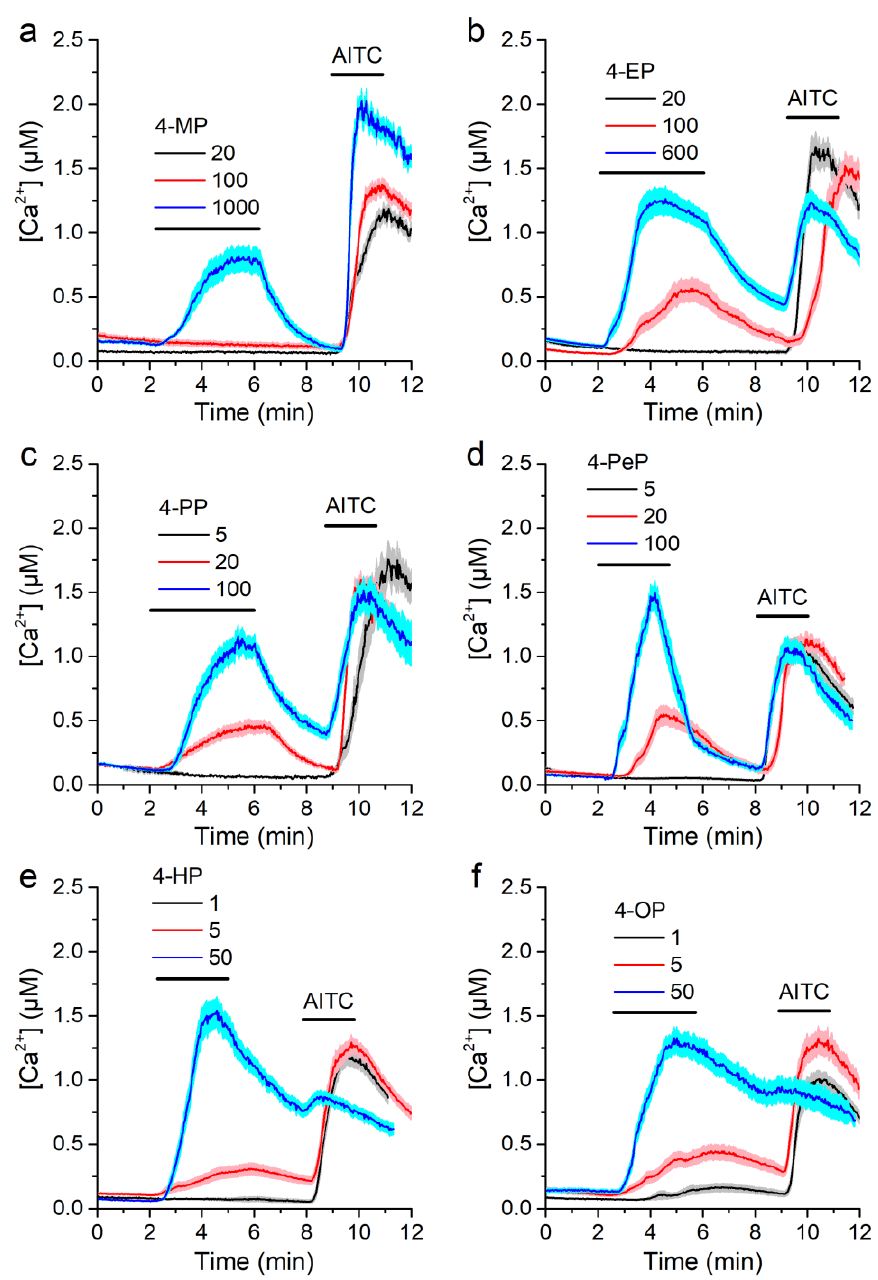
Figure 5. Alkylphenols activate mTRPA1 in a concentration-dependent manner. ( a – f ) Average traces of [Ca 2+ ] recorded in CHO-mTRPA1 cells showing responses to 4-methylphenol (4-MP, a ), 4-ethylphenol (4-EP, b ), 4-propylphenol (4-PP, c ), 4-penthylphenol (4-PeP, d ), 4-heptylphenol (4-HP, e ) and 4-octylphenol (4-OP, f ). AITC 100 µM was applied as a positive control for mTRPA1 activation. Data from n > 50 cells are shown as mean ± s.e.m.